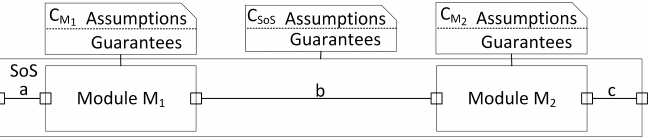
Figure 3. A reduced example of a compositional SoS with two modules connected in series and contracts attached to the parent module and the two sub-modules